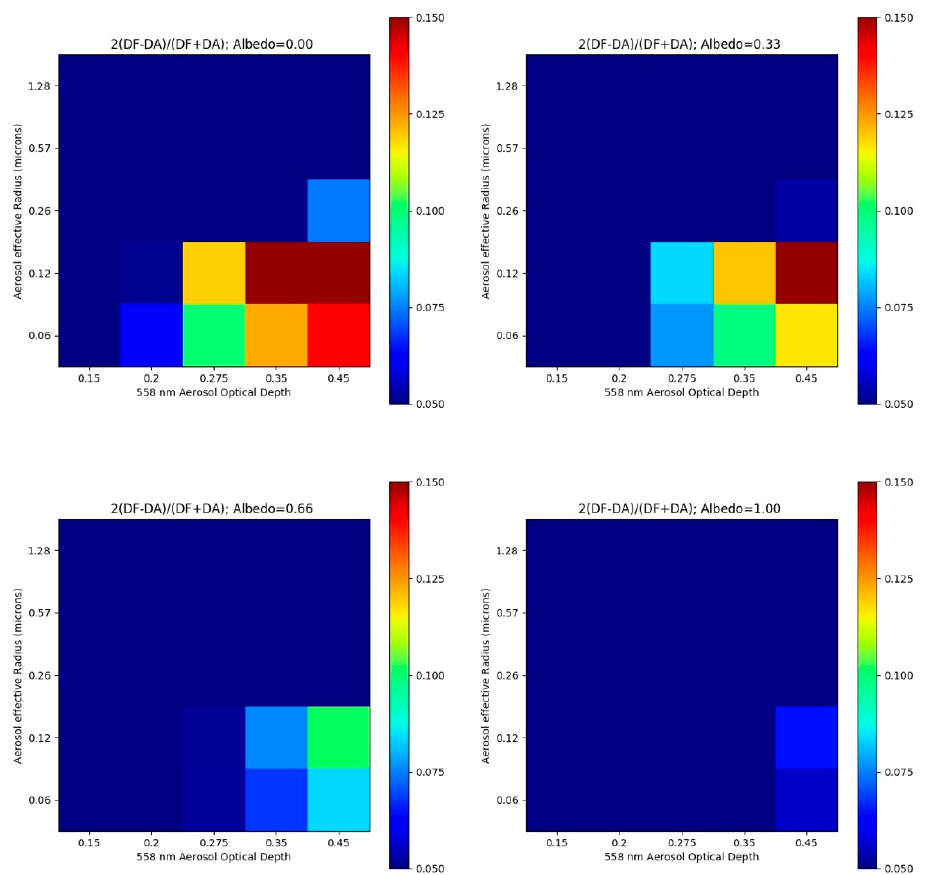
Figure 11. Simulated MISR blue-band anisotropy as a function of AOD558 and effective radius for the 24 June 2009 event over the Beaufort Sea (Figure 4) that originated from Sarychev volcano on 15 June. As constrained by MISR Research Algorithm retrievals (Figure 6 top), AOD is ~0.35 (0.2–0.5) and the particles are modeled as spherical, non-light-absorbing, sulfate analogs. The required particle size is larger than 0.6, which is consistent with the retrieved Angstrom exponent in Figure 4.